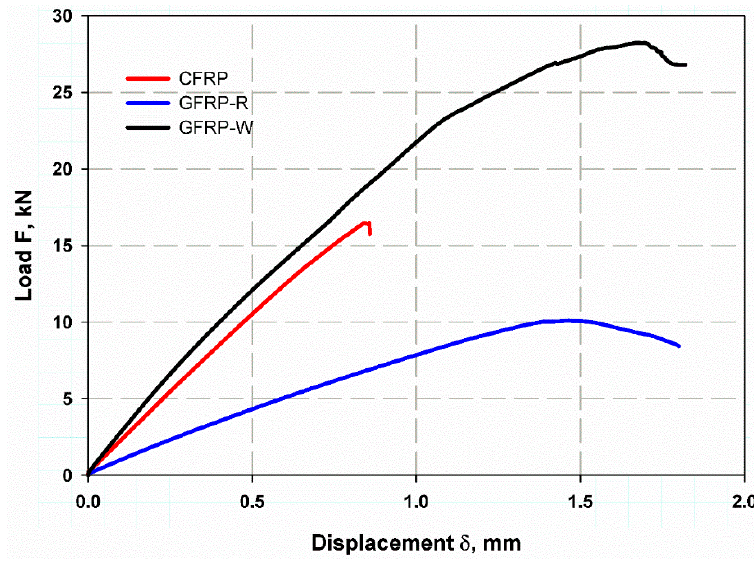
Figure 10. Load and displacement curve of CNT.